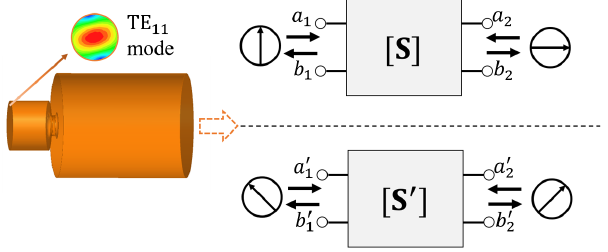
FIG. 20. Schematic diagram of a cavity with a cylinder wave- guide working at the polarized degenerate mode.